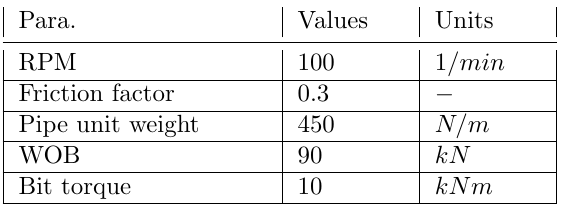
Table 2: Torque model parameters